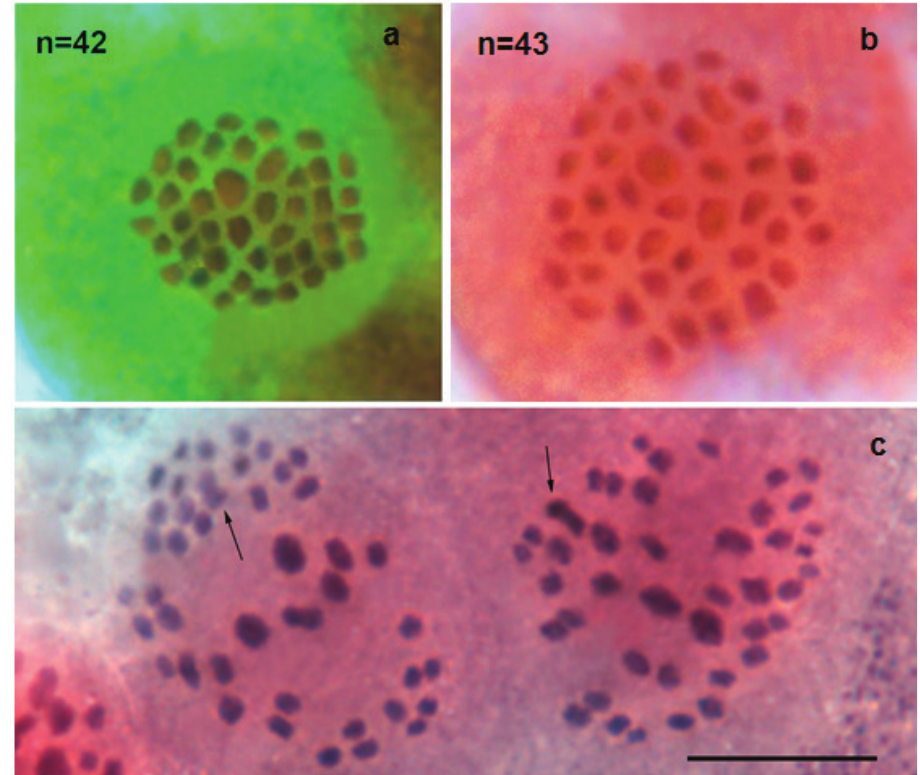
Figure 5. Karyotypes of Polyommatus lurae sp. nov from Albania a sample K73, MII, n=42 b sample K82, MII, n=43 c sample K71, two MI cells, each cell displays 41 bivalents and one possible trivalent (arrow). Scale bar: 10